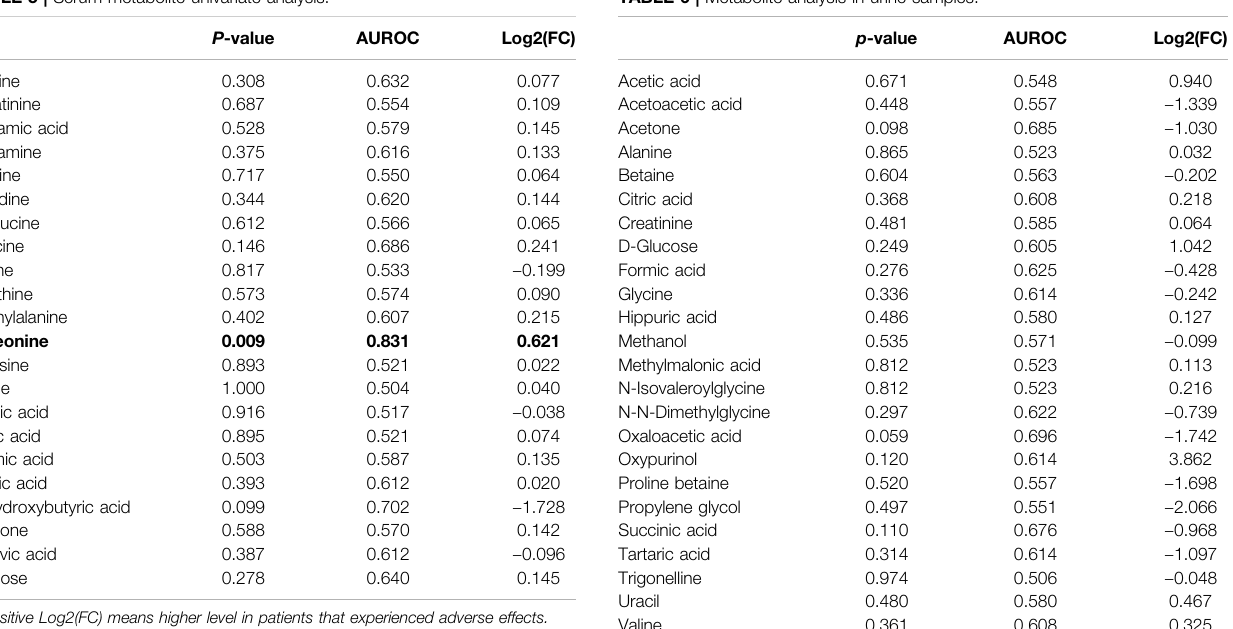
TABLE 5 | Serum metabolite univariate analysis. TABLE 6 | Metabolite analysis in urine